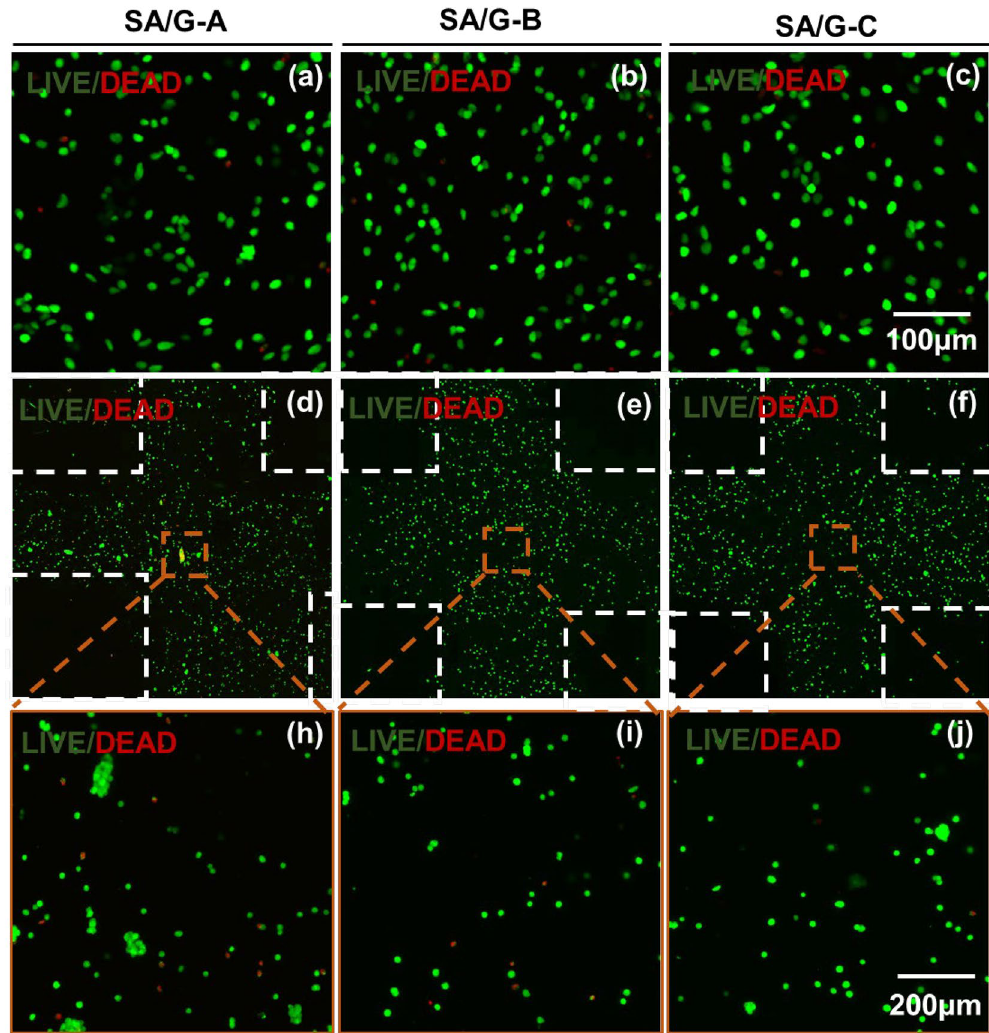
Figure 5. Cell distribution analysis. LIVE-DEAD staining cells before printing in ( a ) SA/G-A, ( b ) SA/G-B, and ( c ) SA/G-C hydrogel; ( d )–( f ) The cell LIVE/DEAD staining of ( a ), ( b ) after printing,